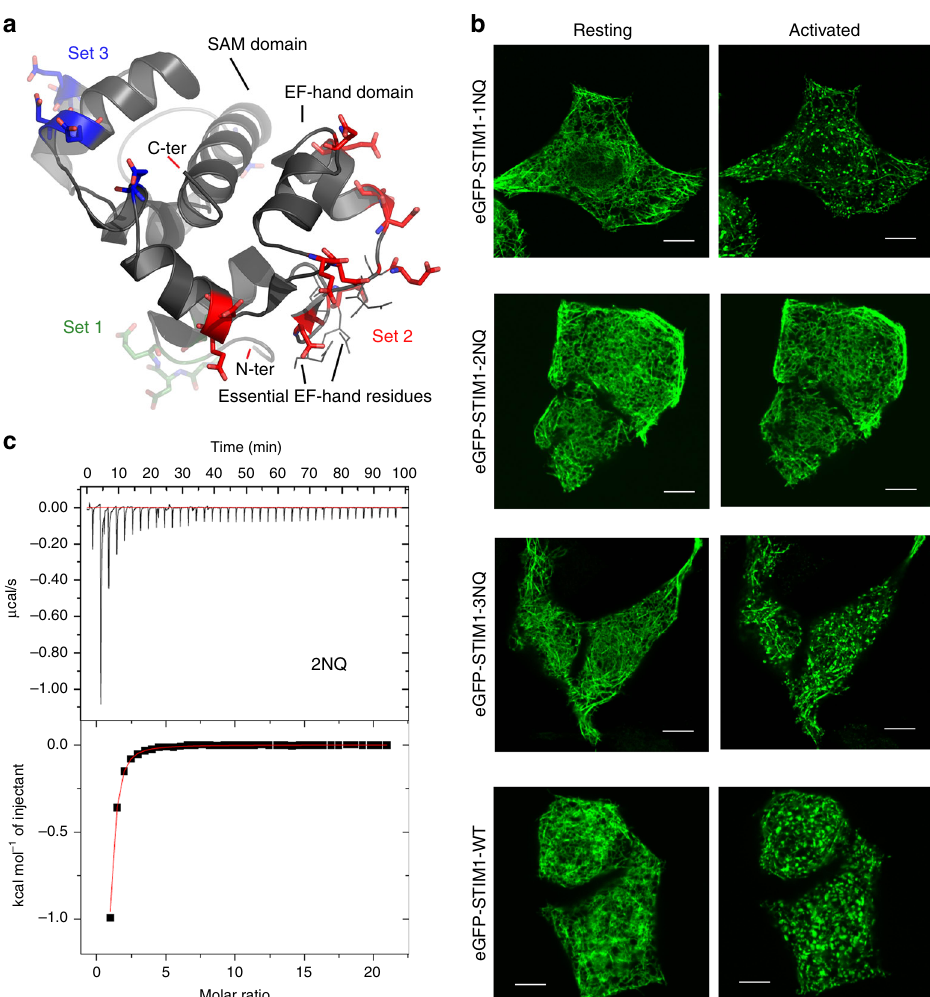
Fig. 4 Identi fi cation of an EFSAM surface that regulates STIM1 Ca 2 + binding and puncta formation. a Three sets of surface residues (stick representation) studied in this work, marked on the cartoon diagram of EFSAM structure (PDB ID: 2K60). Region 1 comprises four acidic residues near the EFSAM N terminus, region 2 comprises eleven acidic residues spanning the exposed surface of the two EF-hands, and region 3 comprises six residues on a surface of the SAM domain. b Confocal micrographs of HeLa cells expressing eGFP-STIM1-1NQ, eGFP-STIM1-2NQ, eGFP-STIM1-3NQ, or wild-type eGFP-STIM1, at rest (left panels) and after store depletion with 1 μ M thapsigargin (TG) (right panels). Scale bars, 5 μ m. c ITC analysis of EFSAM-2NQ. Top panel, heat changes measured by injecting 1 μ l aliquots of 25 mM Ca 2 + into a sample cell containing initially 252 μ M protein. Bottom panel, integrated binding isotherm as a function of molar ratio (Ca 2 + : protein) after subtracting heats of